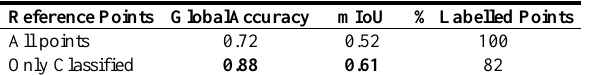
Table 5 . Back-projection results for 3_SSA.